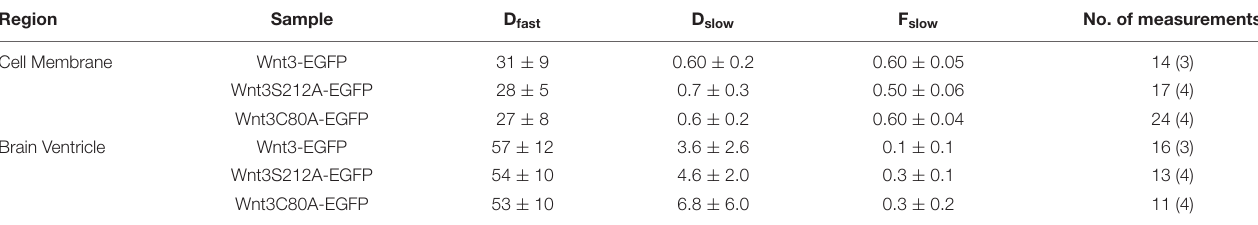
TABLE 1 | Diffusion coefficients of Wnt3-EGFP, Wnt3C80A-EGFP and Wnt3S212A-EGFP in cell membrane and fourth brain ventricle as measure by confocal FCS. Region